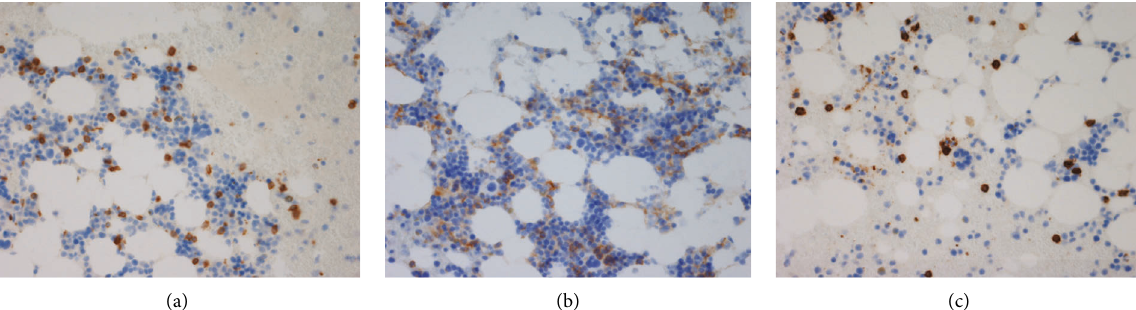
Figure 3: Bone marrow specimens in 2021: (a) CD3-positive T-cells around the myeloma cells ( × 40). (b) CD4-positive T-cells around the myeloma cells did not increase in number ( × 40). (c) CD8-positive T-cells around the myeloma cells ( ×